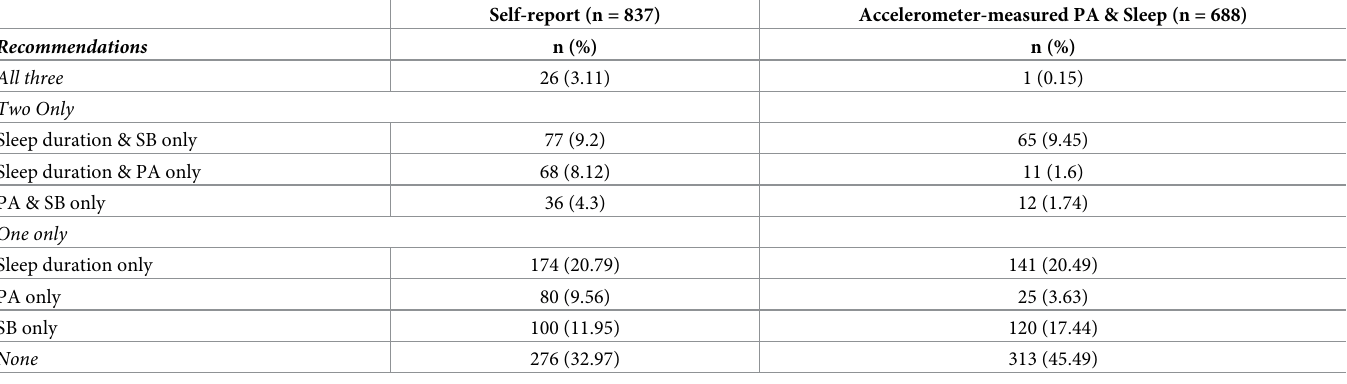
Table 2. Proportion of participants meeting the MVPA, screen time, and sleep duration recommendations and various combinations based on self-report and accelerometer